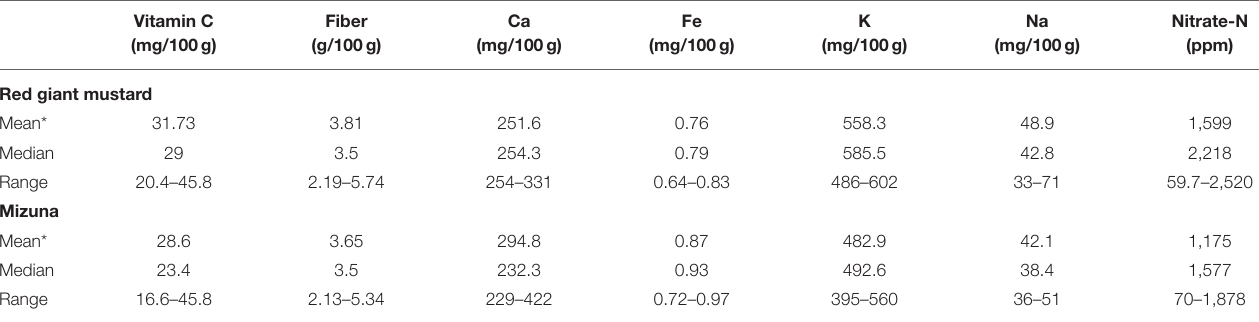
TABLE 6 | Conventionally grown produce collected throughout both experiments from three Minnesota growers and greenhouses. Vitamin C